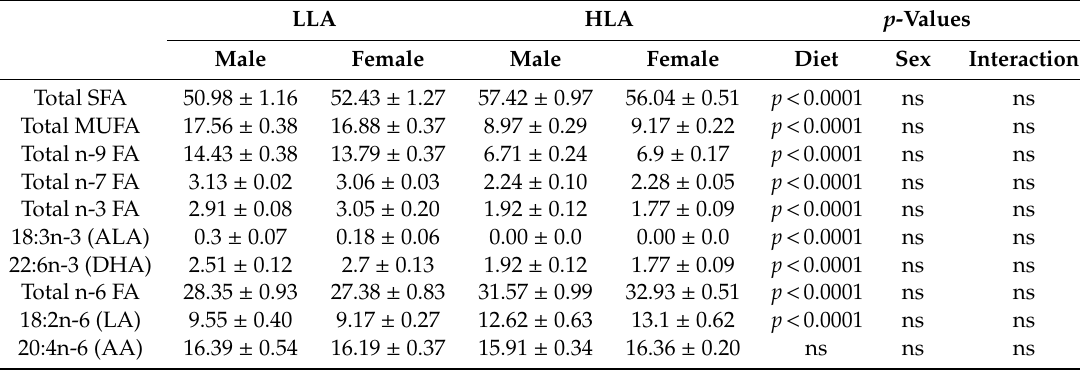
Table 1. E ff ect of a maternal diet high in linoleic acid on fatty acid composition (% of total lipid plasma fatty acid) in the labyrinth zone of the rat placenta. LLA HLA p -Values Male Diet Sex Interaction